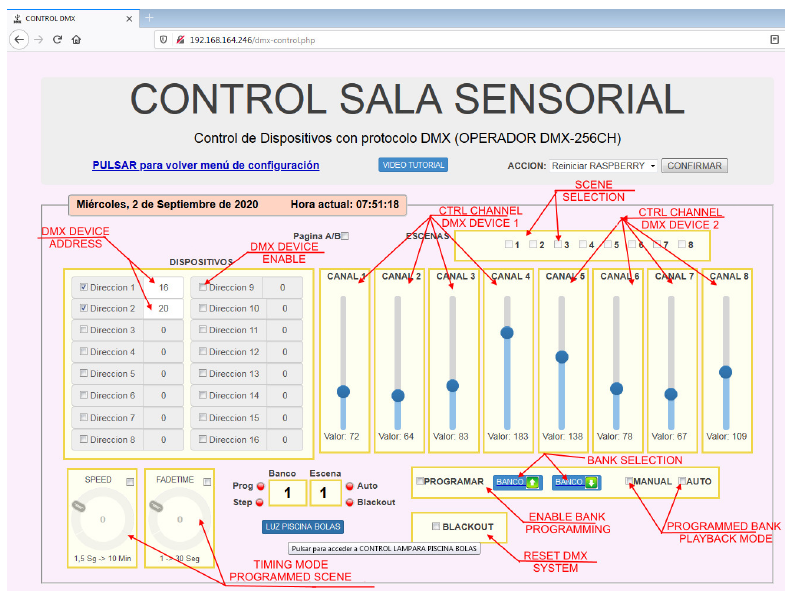
Figure 21. Teacher’s interface for control in context anticipation service.